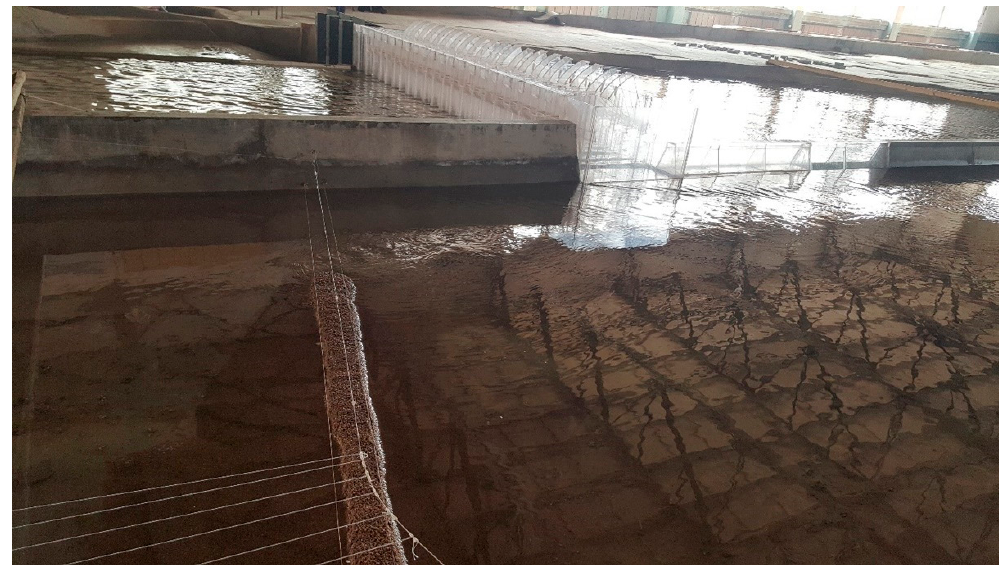
Figure 3. Field photo of physical experiment.